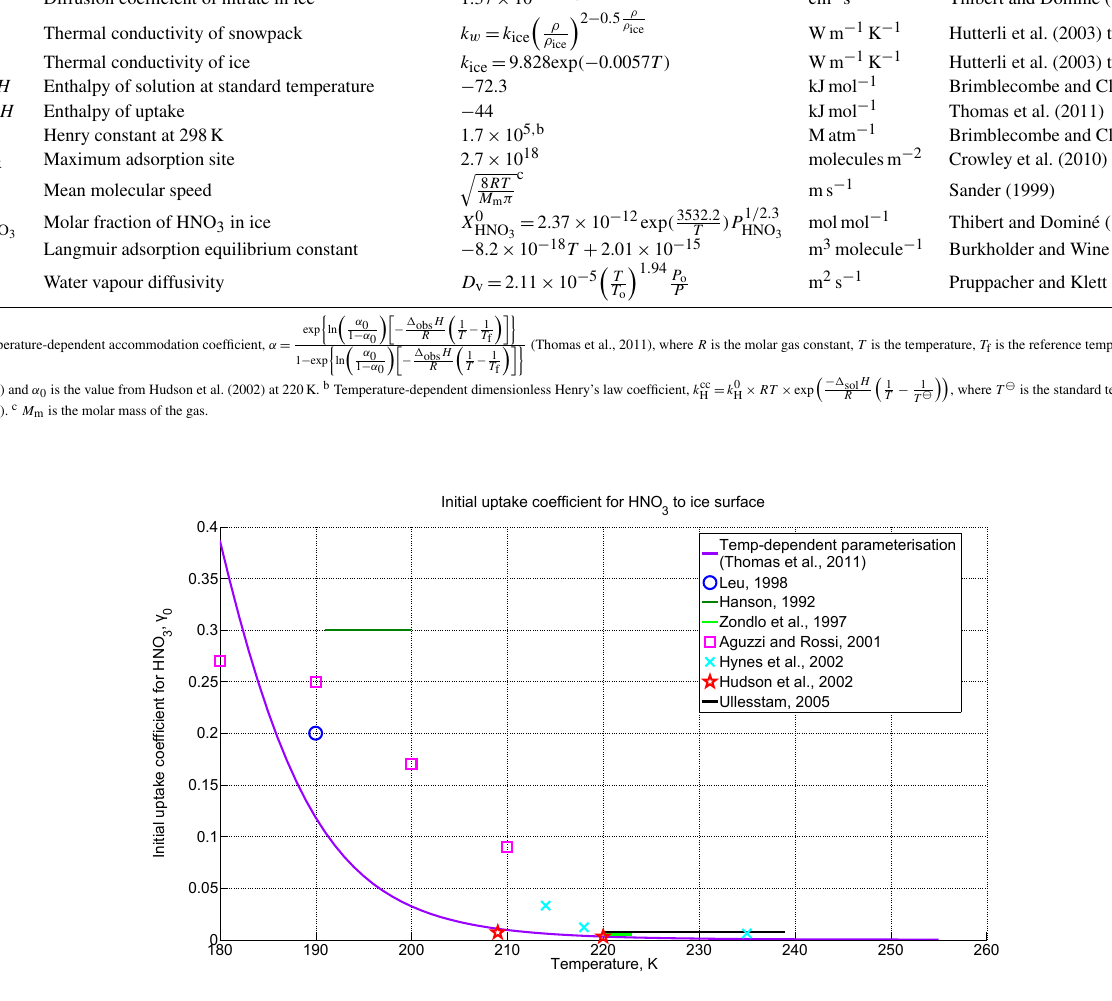
Figure B1. Initial uptake coefficient for HNO 3 as a function of temperature obtained from different studies. In this study the parameterisation of α(T ) with α 0 after Hudson et al. (2002) is used (Table B1, solid purple line) and is chosen to give the best representation of the dependency on